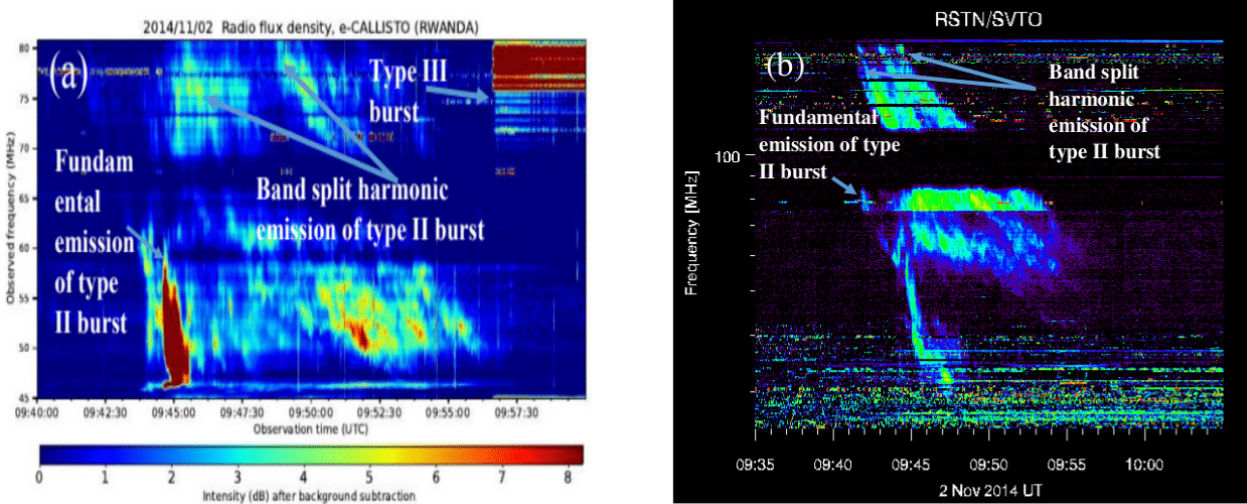
Figure 5. (a) The dynamic spectrum of the 2 November 2014 type II burst followed by type III burst detected by the CALLISTO station in Rwanda. (b) The same dynamic spectrum of the 2 November 2014 burst detected from the Radio Solar Telescope Network (RSTN) at the San Vito (SVTO) station in Italy. The observed type III is of low quality, and it was only detected by CALLISTO, which proves its capacity to detect radio emissions.